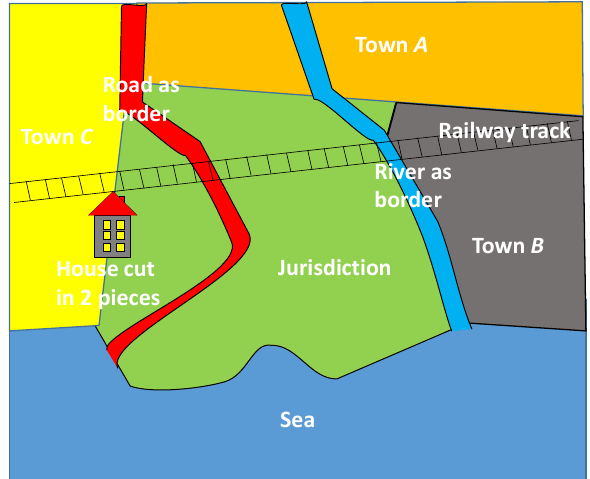
Figure 2. Several types of borderlines and geographic